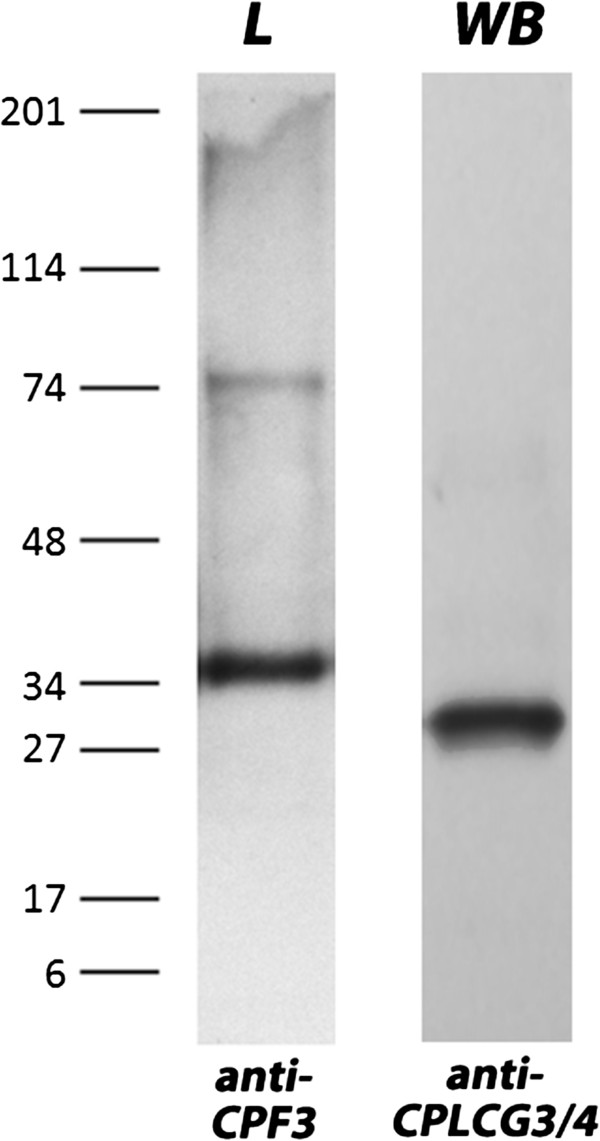
Western blots of crude protein extracts. Extracts from legs (L) and whole body (WB) treated with anti-CPF3 (diluted 1,000-fold) and anti-CPLCG3/4 (diluted 30,000-fold). Detection was with horseradish peroxidase-linked secondary antibodies, sheep anti-mouse (GE Healthcare, NA931) and goat anti-rabbit Sigma, A0545). Molecular weight marker is in kDa.